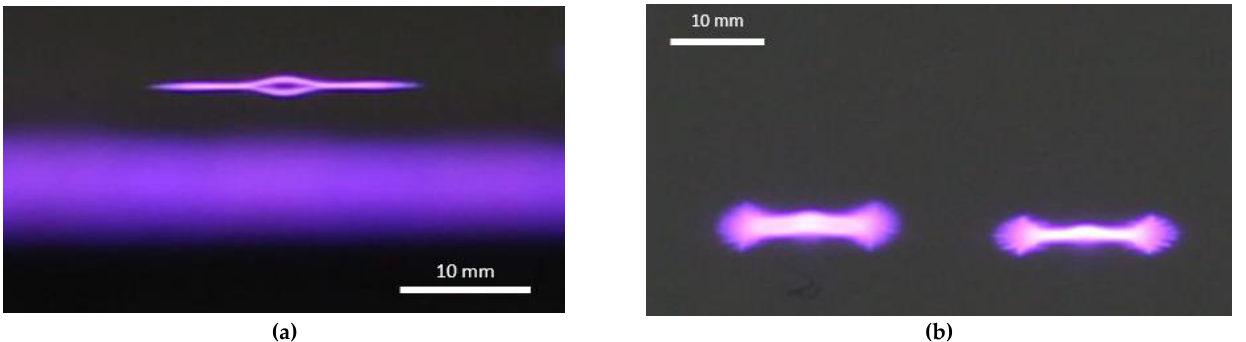
Figure 5. Fallout of active particles that are generated and released from the free surface of the ceramic dielectric during the generation of a DCSBD plasma discharge. This is followed by an interaction with the averted surface of the modified material, causing an indirect modification of surface B. Probably, magnetic field alongside electrodes/ceramic dielectric supports this effect. Front view.